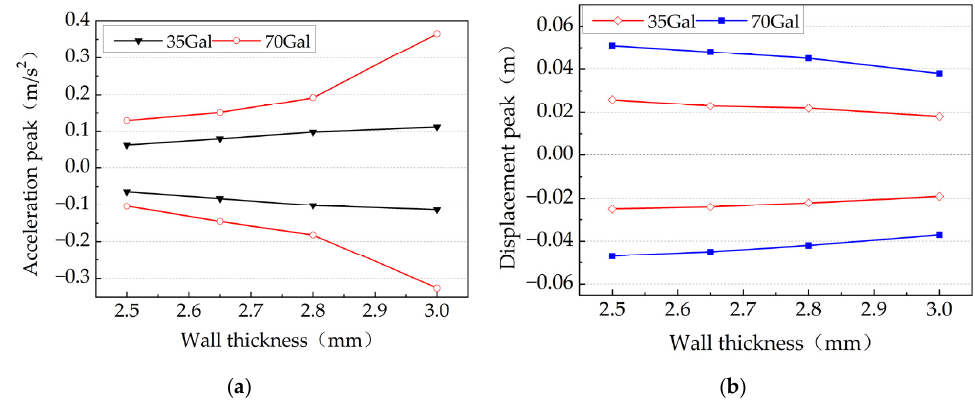
Figure 28. Dynamic response of structure under the Nihonkai-Chubu earthquake: ( a ) Comparison of acceleration peak; ( b ) Comparison of displacement peak.